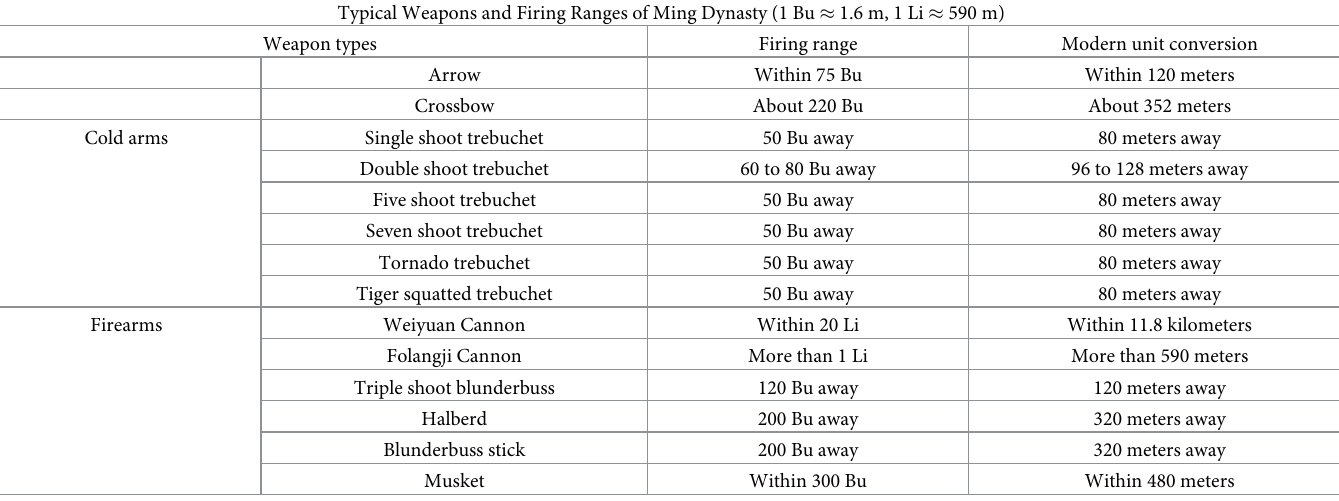
Table 1. Typical weapons and firing ranges of ming dynasty (source: Compiled and converted according to the Wu Bei Zhi and Fang Shou Ji